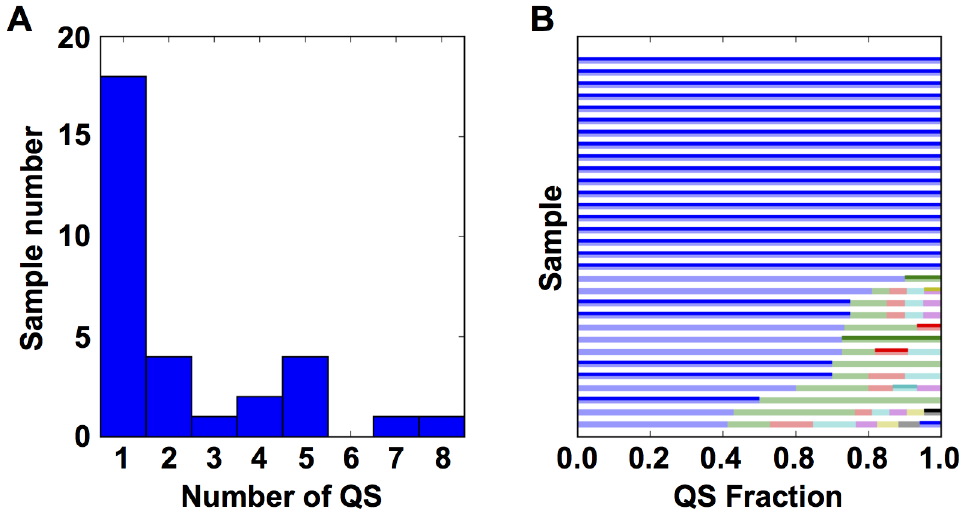
Fig 1. Direct sequencing of PCR products generated directly from genomic DNA very often returns the predominant genotype. (A) (Left) A histogram of the number of QS observed in each of the 31 samples with at least 10 Clone Reads. (B) A bar plot showing the fraction of the total observed QS for each unique Clone Read. Each horizontal bar represents one of the 31 samples with the width of the bar indicating the QS fraction. Each color in the bar indicates unique QS. Darker bars denote the QS that match the PCR